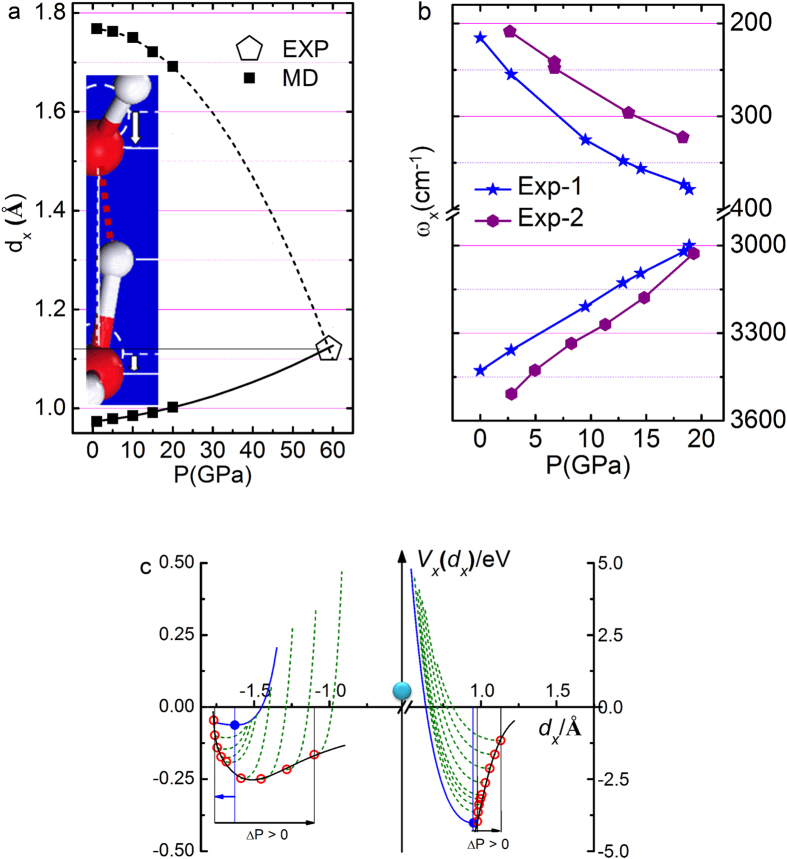
Pressure induced O:H-O bond relaxation in the (a) segmental length dx, (b) phonon frequencies ωx3031, and (c) potential paths ux(r) for the O:H-O bond relaxing with pressure (l. to r.: P = 0, 5, 10, 15, 20, 30, 40, 50, 60 GPa)21; blue dots correspond to OH-O bond without Coulomb repulsion being involved.The dx curves in (a) meet at the point of proton centralization occurring in phase X at 59 GPa and 0.22 nm2930. The O:H nonbond and H-O bond responses to compression oppositely (see inset a).